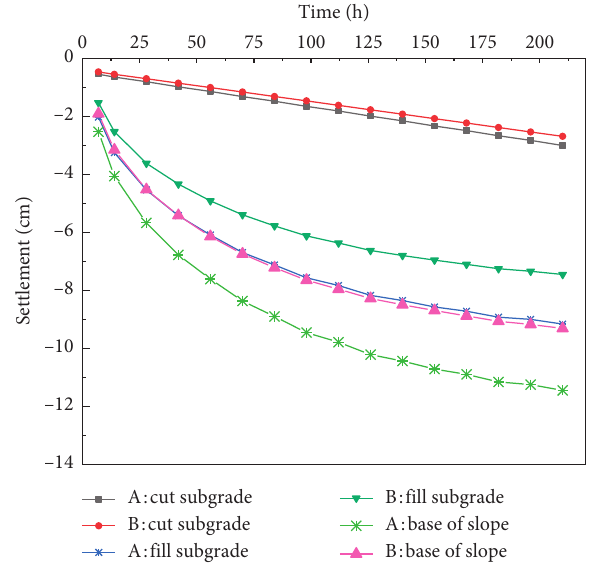
Figure 16: Development law of settlement of the longitudinal cut to fill